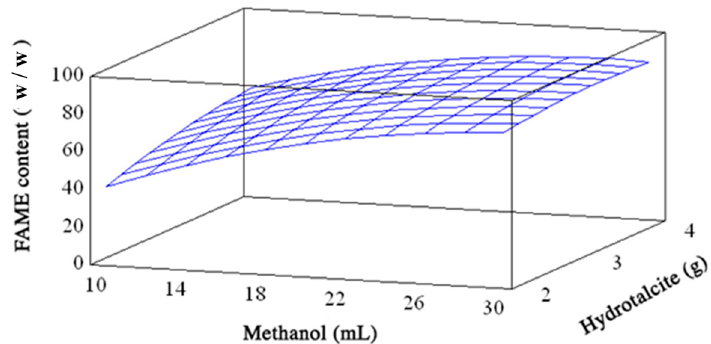
Figure 3. Surface response for FAME content under optimal reaction time (3.12 h).